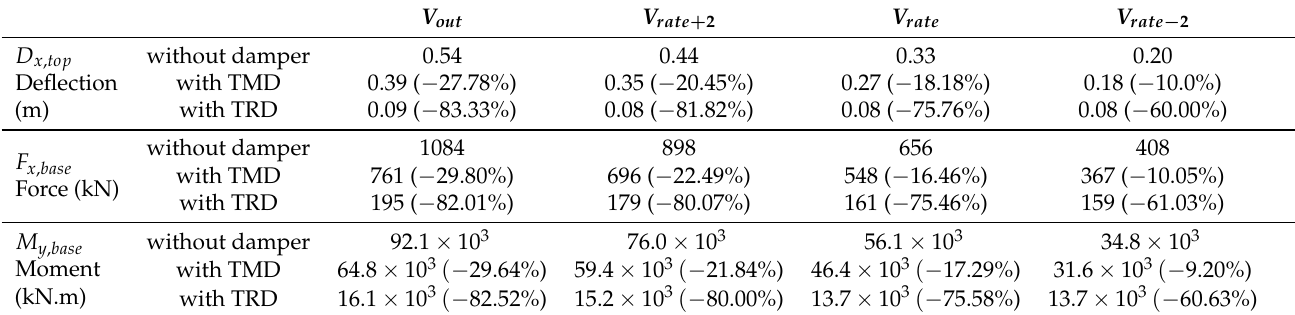
Figure 10. Status of TRD in DLC2.3 at V out (the time dependency is omitted in the legend). Table 4. Peak-to-peak amplitude of the tower response (with the reduction rate (cid:101) presented between